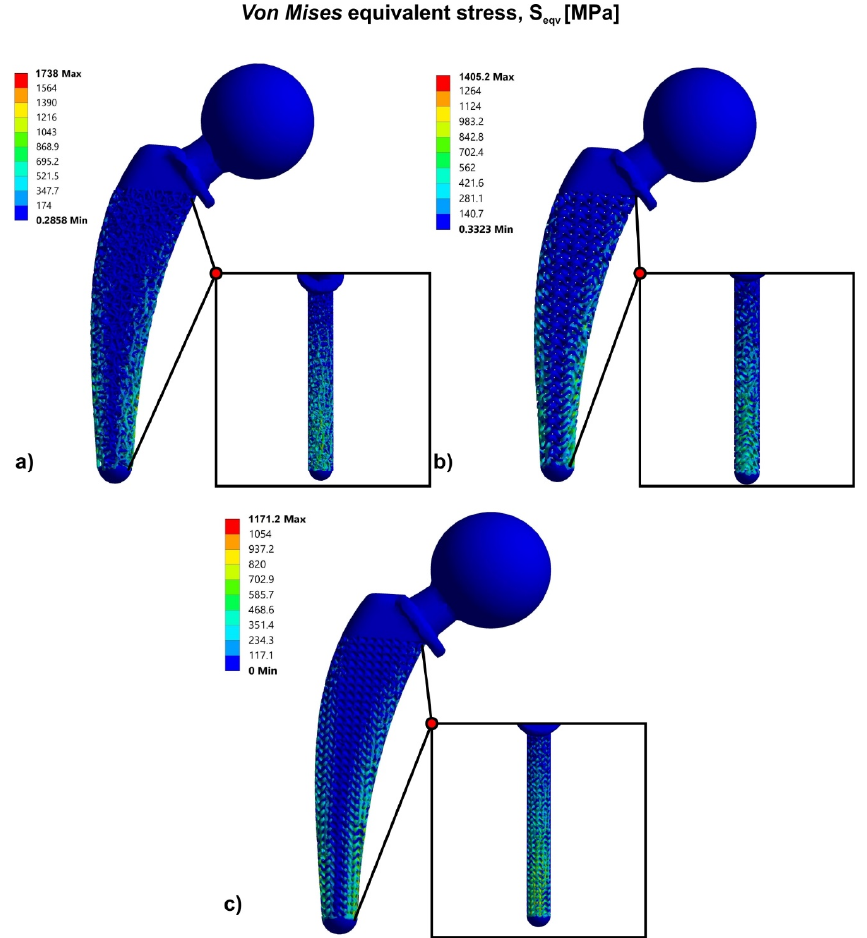
Figure 7. Von Mises stress contours for: ( a ) Voronoi structure; ( b ) Gyroid structure; ( c ) Schwarz Diamond structure.